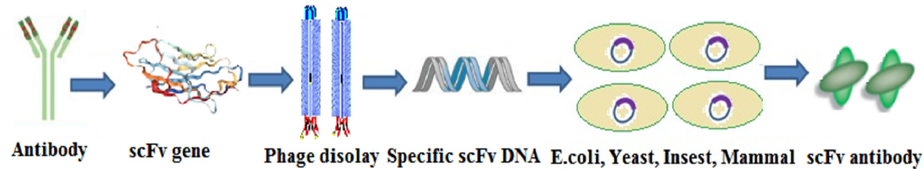
Figure 12. The scFv preparation process.